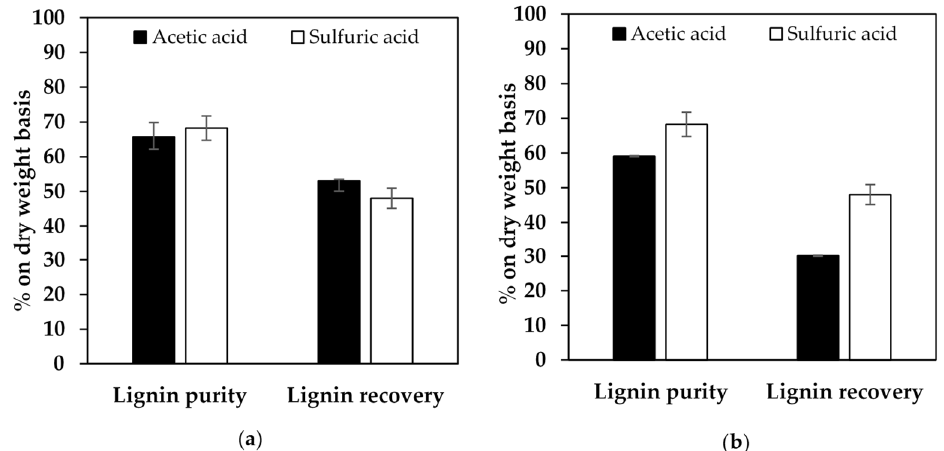
Figure 1. Effect of (a) catalysts type (added in different concentration to reach pH 3) and (b) catalyst concentration (added in the same concentration, 0.13% (w/w)) on lignin purity ( p- value = 0.444 and p- value = 0.035, respectively) and recovery (p- value = 0.076 and p- value = 0.007, respectively). Error bars represent ± 2× the standard deviation.